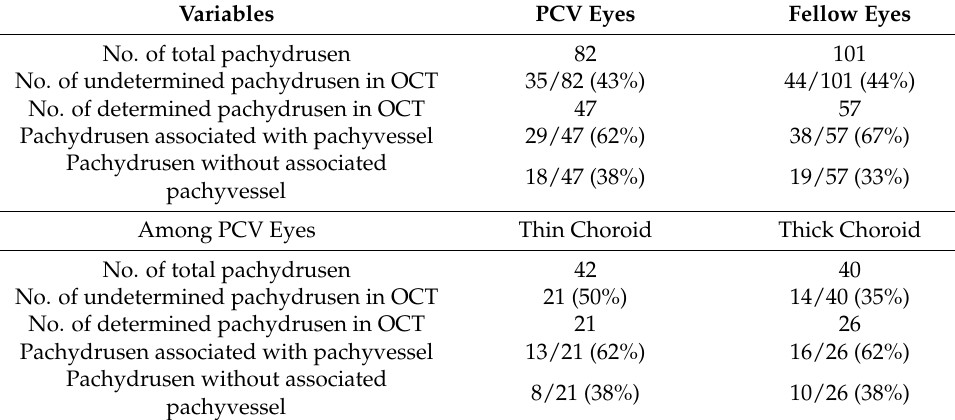
Table 4. Association of pachydrusen and pachyvessel in PCV eyes and fellow